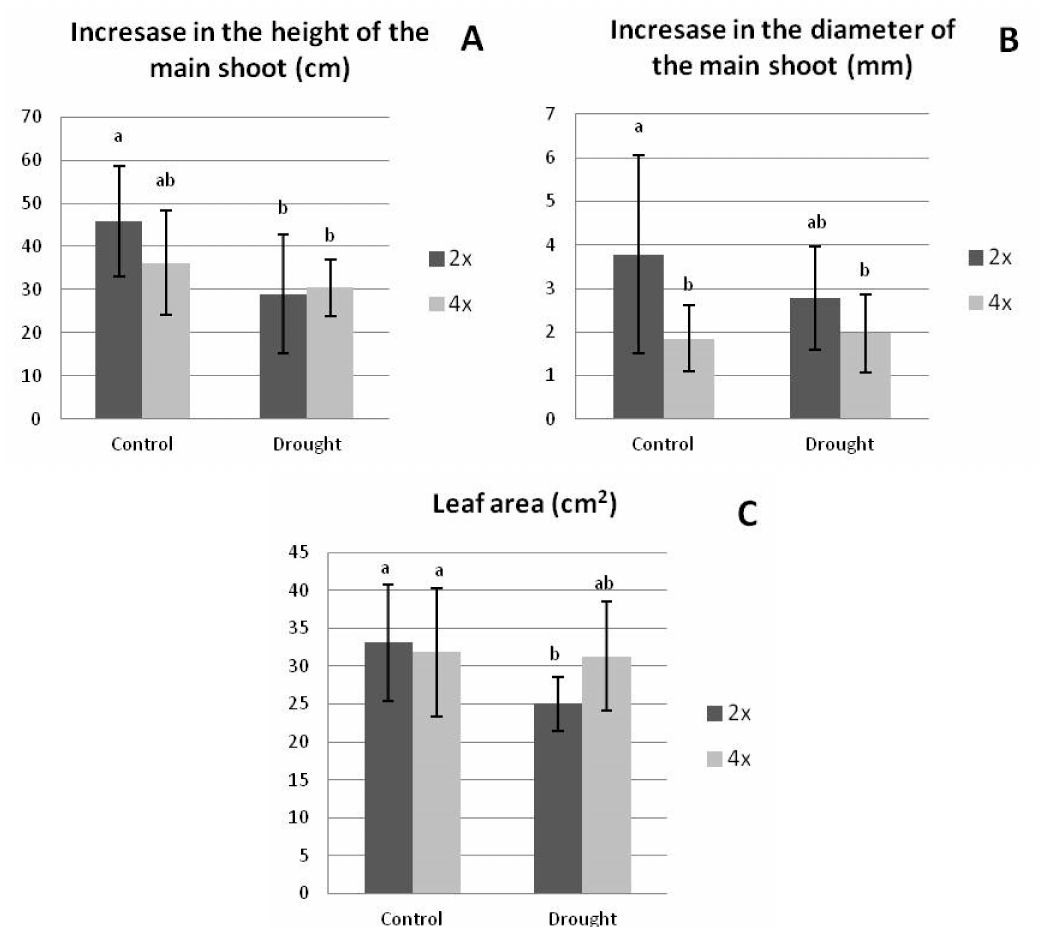
Figure 7. Growth parameters of diploid (2x) and tetraploid clone 4x-25 of the apple cv. ‘Redchief’, optimally irrigated and subjected to drought stress: ( A ) increase in the height of the main shoot, ( B ) increase in the diameter of the main shoot, ( C ) leaf area. Bars marked with the same letter do not differ significantly at p = 0.05; Duncan’s test.